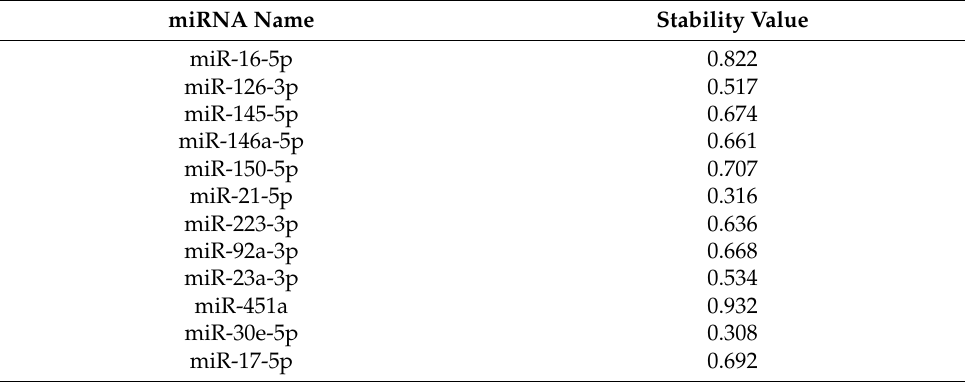
Table A3. The NormFinder stability values for the miRNAs analyzed by